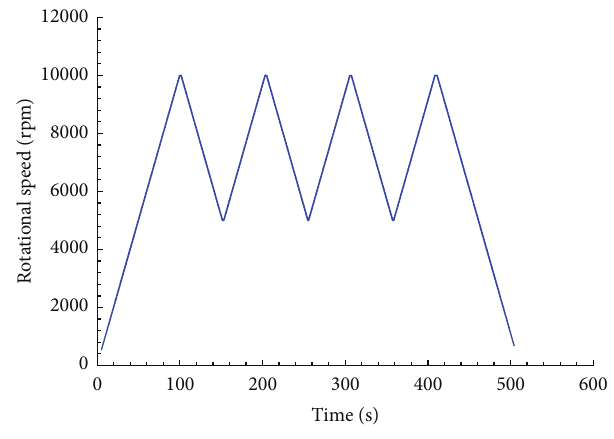
Figure 8: Simulated mission